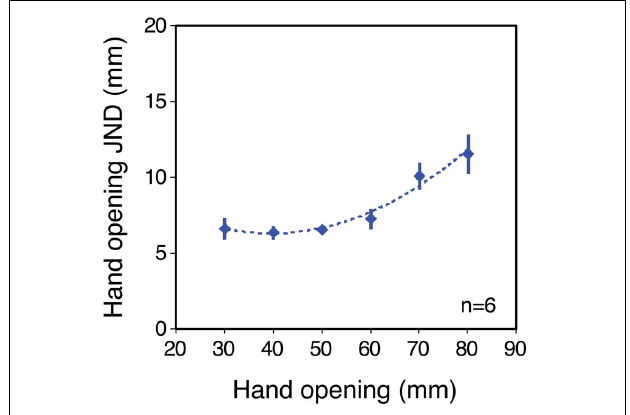
FIGURE 3 | Sensitivity to hand opening in the no-tool condition. The figure plots JNDs in hand opening as a function of hand opening, averaged across the six observers (for individual results, see Supplementary material). The dashed line shows a second-order polynomial fit to the data, used to generate predictions for the tool conditions. Error bars denote ± 1 standard